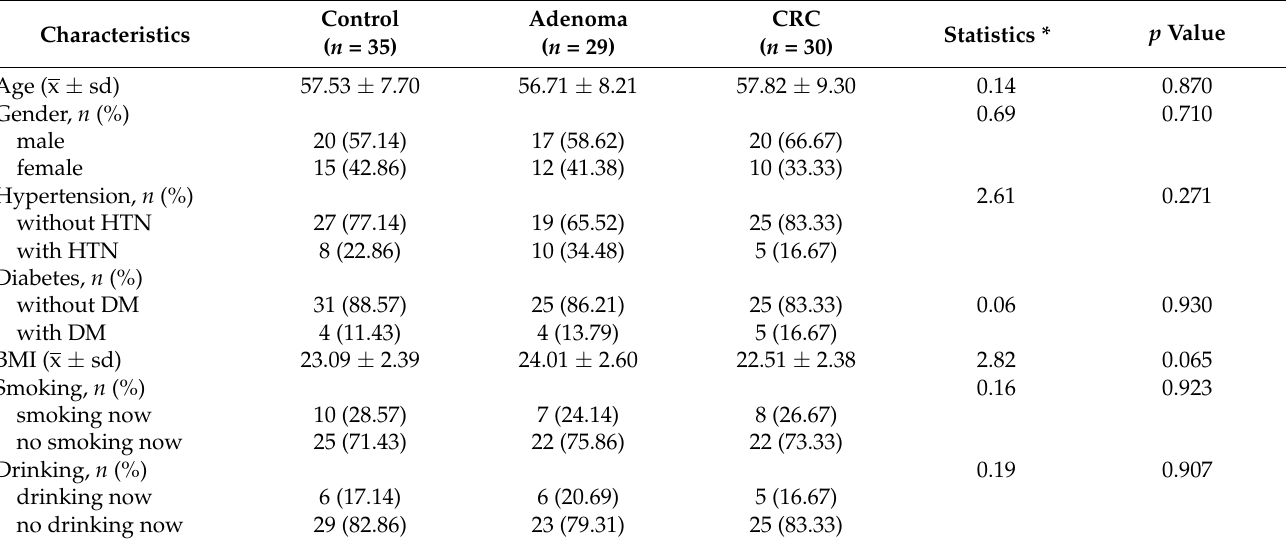
Table 1. Characteristics of colorectal adenoma cases, colorectal cancer cases, and controls in our discovery